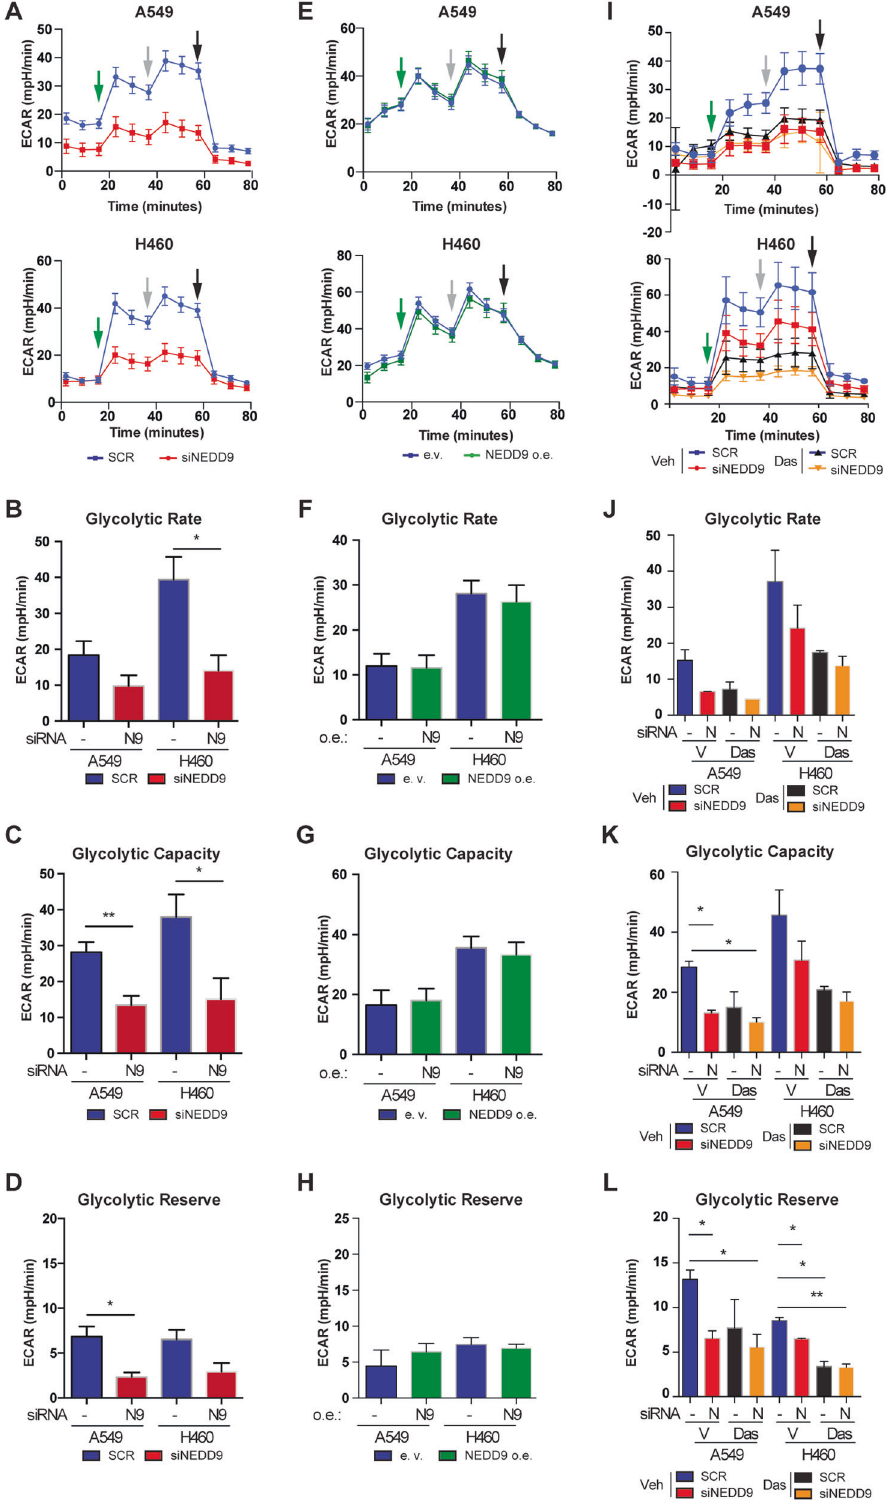
Fig. 1 Depletion of NEDD9 in human NSCLC cell lines impairs glycolysis. A Seahorse results in A549 and H460 cells treated with siRNA to NEDD9 (red) or scrambled siRNA (SCR, blue). Glycolysis is determined by measuring lactic acid acidi fi cation of the media. Arrows indicate addition of glucose (green), oligomycin (gray), and 2DG (black). B – D . Quantitation of results from ( A ) to demonstrate differences in glycolytic rate ( B ), glycolytic capacity ( C ), and glycolytic reserve ( D ). E – H Experiments parallel those shown in ( A – D) , but in conditions of 48 h of overexpressed NEDD9 (green) contrasted to cells transfected with empty vector (e.v., blue). I – L Experiments parallel those in ( A – D ), but in cells treated with vehicle or dasatinib. ECAR, extracellular acidi fi cation rate. Graphs shown represent average of three independent experiments. * p < 0.05, ** p < 0.01; error bars represent